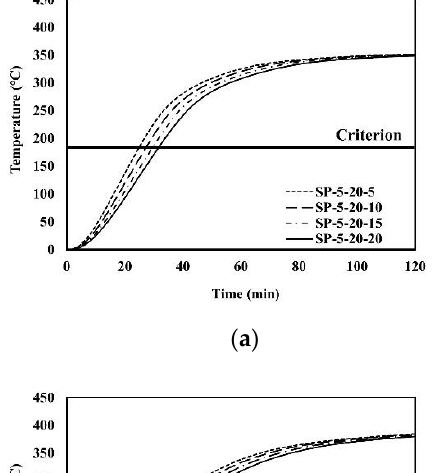
Figure 14. Time history of average temperatures with d p = 20 mm: ( a ) SP-5-20- x; ( b ) SP-10-20-x; ( c ) SP-15-20-x; ( d ) SP-20- 20-x.